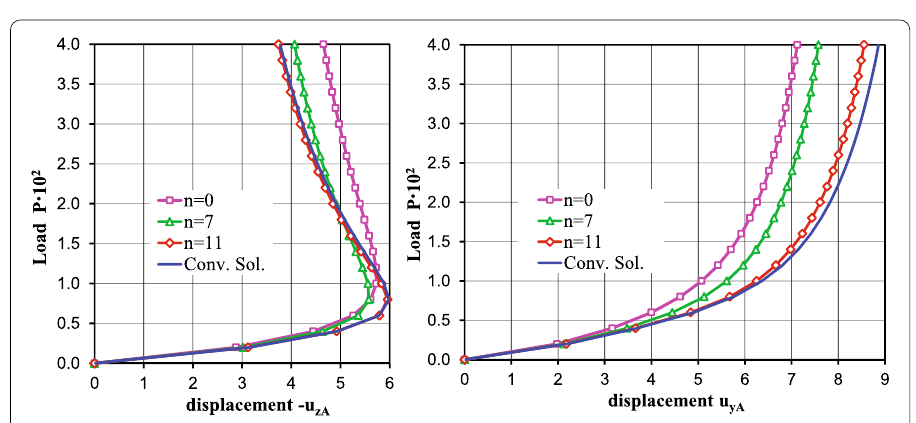
Fig. 21 Twisted beam: P − u zA and P − u yA for the distorted 4 × 24 mesh 2